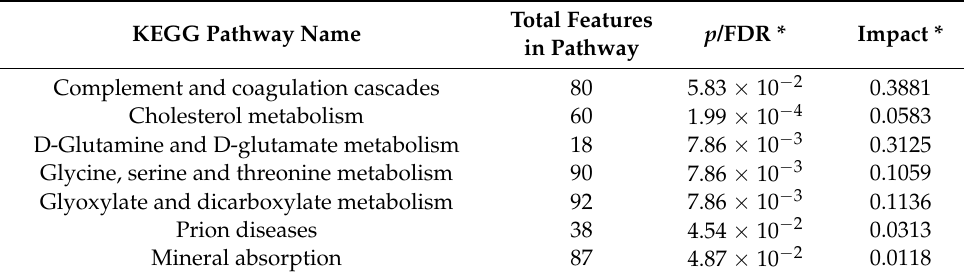
Table 5. KEGG pathways affected by intervertebral disc herniation in dogs observed in cerebrospinal fluid as obtained using MetaboAnalyst taking into consideration significantly deregulated proteins and metabolites.